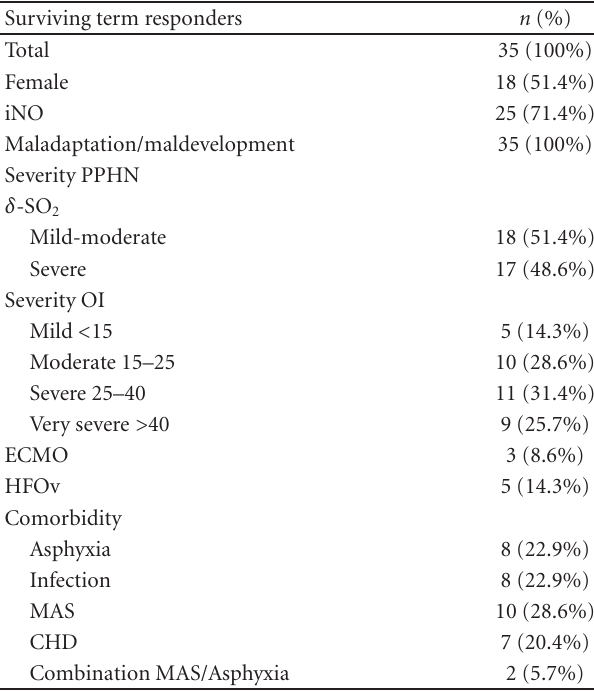
Table 3: Patient characteristics of surviving patients. Table 4: Patient characteristics of term surviving